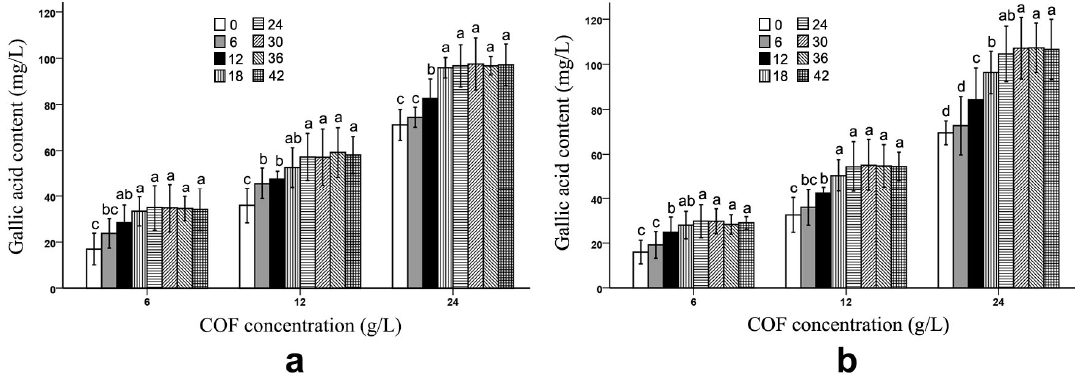
Figure 4. Gallic acid content in Cornus officinalis fruit (COF) culture broth at different concentrations and fermentation times of Bacillus subtilis and Bifidobacterium bifidum . ( a ) Gallic acid content in COF culture broth at different concentrations and fermentation duration of B. subtilis . ( b ) Gallic acid content in COF culture broth at different concentrations and fermentation duration of B. bifidum . Data are the means ± SD from three independent tests. Different letters (a, ab, b, bc, c, and d) on the error bars indicate significant differences at p < 0.05 between the gallic acid contents of different fermentation durations on the same COF concentration and strain. The significant differences ( p < 0.05) of the mean values were detected by T